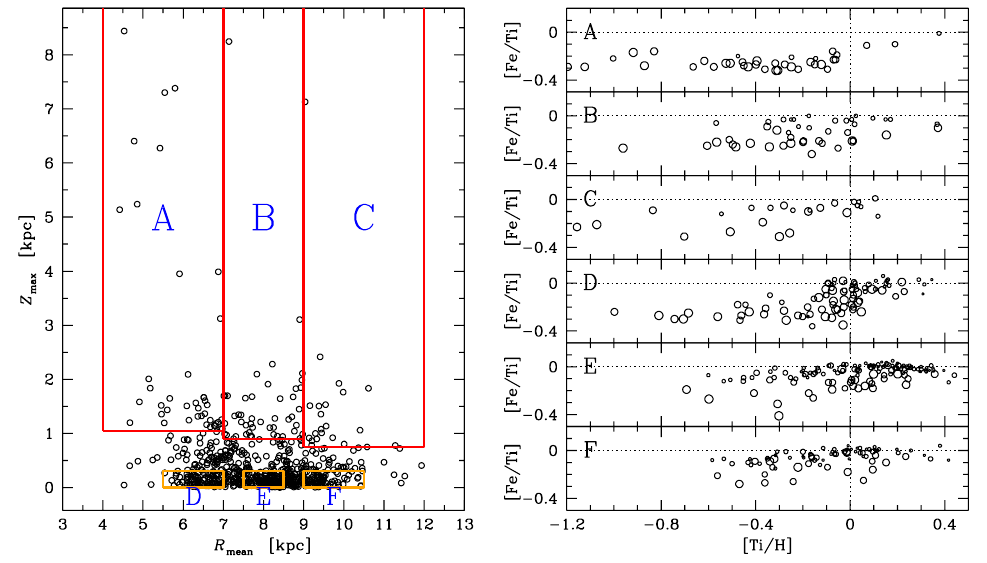
Figure 4. Left: z max versus R mean . Right: [Fe/Ti]-[Ti/H] for stars with orbital parameters as shown in boxes A-F in the plot on the left-hand side. The sizes of the circles have been scaled with the estimated ages of the